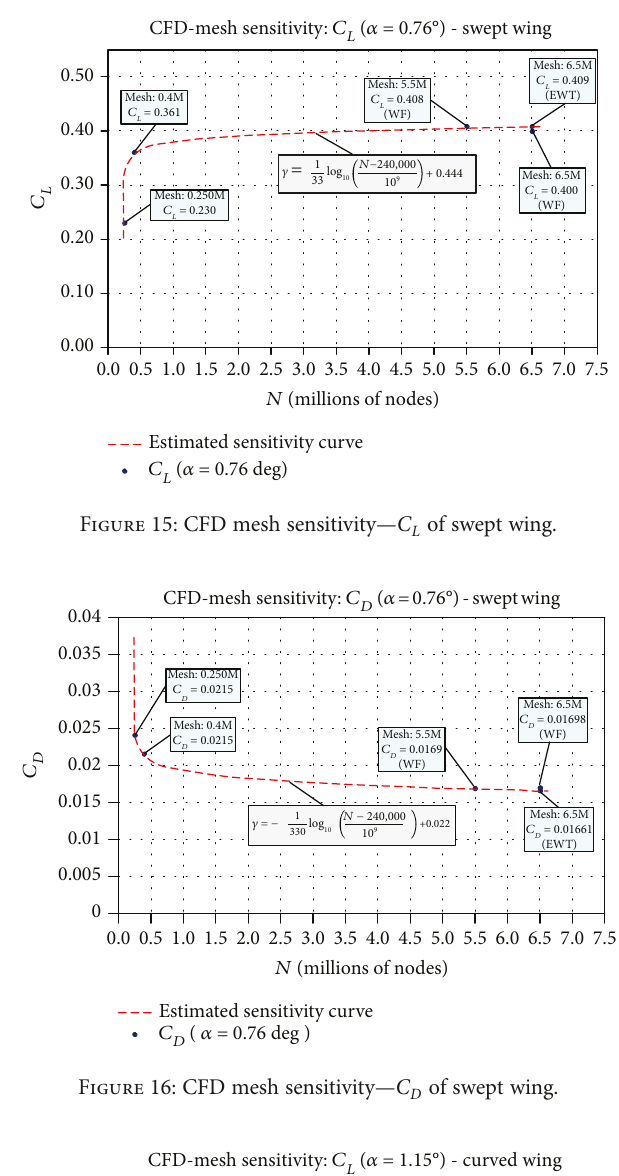
D of swept wing.